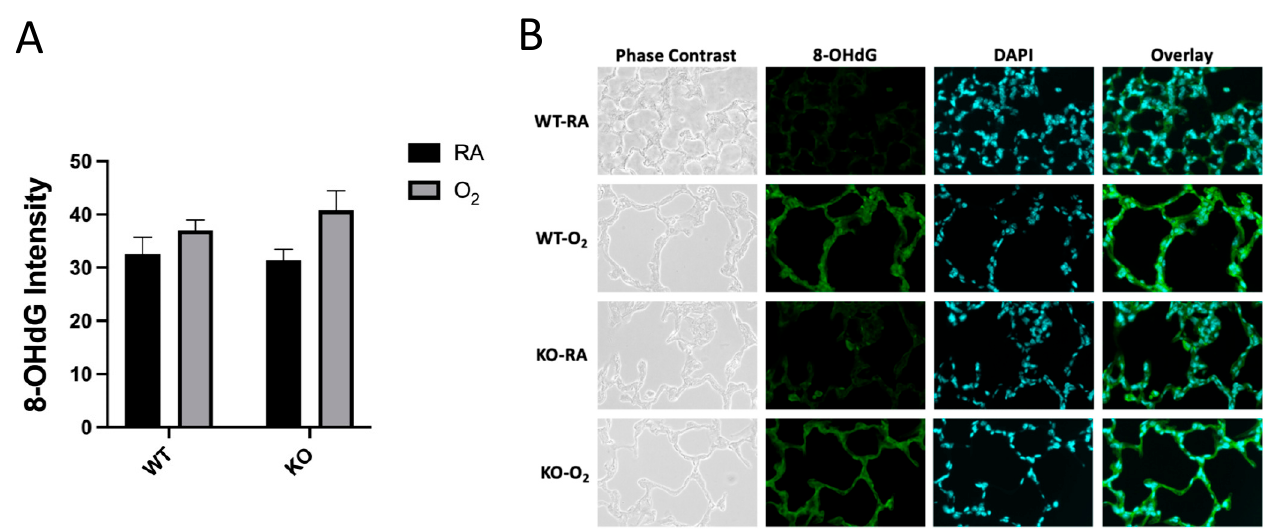
Figure 3. SOD3 KO did not affect DNA oxidation. ( A ) Lung sections were stained for 8-OHdG and counterstained with DAPI. Nuclei were identified on the basis of DAPI fluorescent intensity, and these regions were analyzed for 8-OHdG fluorescent intensity to avoid analyzing background autofluorescence. There was an overall increase in 8-OHdG fluorescent intensity in hyperoxia-exposed mice by two-way ANOVA ( p < 0.05); however, post hoc individual group comparisons did not reach statistical significance. ( B ) Representative images of phase-contrast, 8-OHdG immunofluorescent (green), and DAPI-stained (blue) lungs are presented. An overlay of the 8-OHdG and DAPI images is shown in the far-right column.